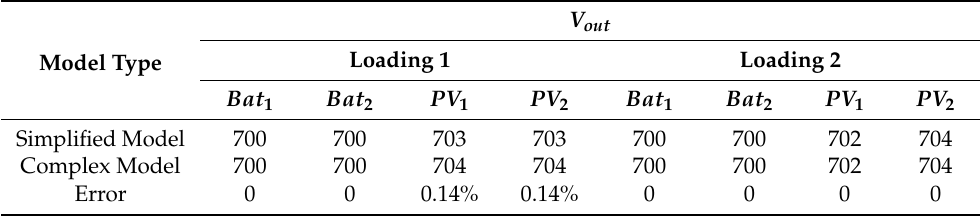
Table 4. The comparison results for output